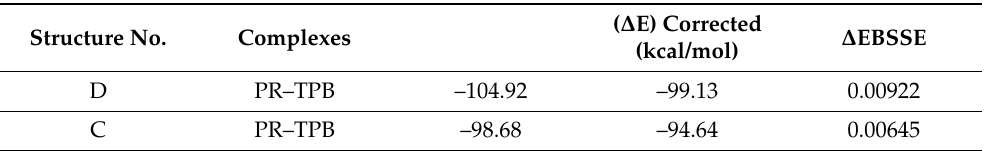
Table 2. Interaction energies with the ( ∆ E)corrected and ∆ EBSSE (kcal mol − 1 )respectively, at the B3LYP/6-311G(d,p) level of